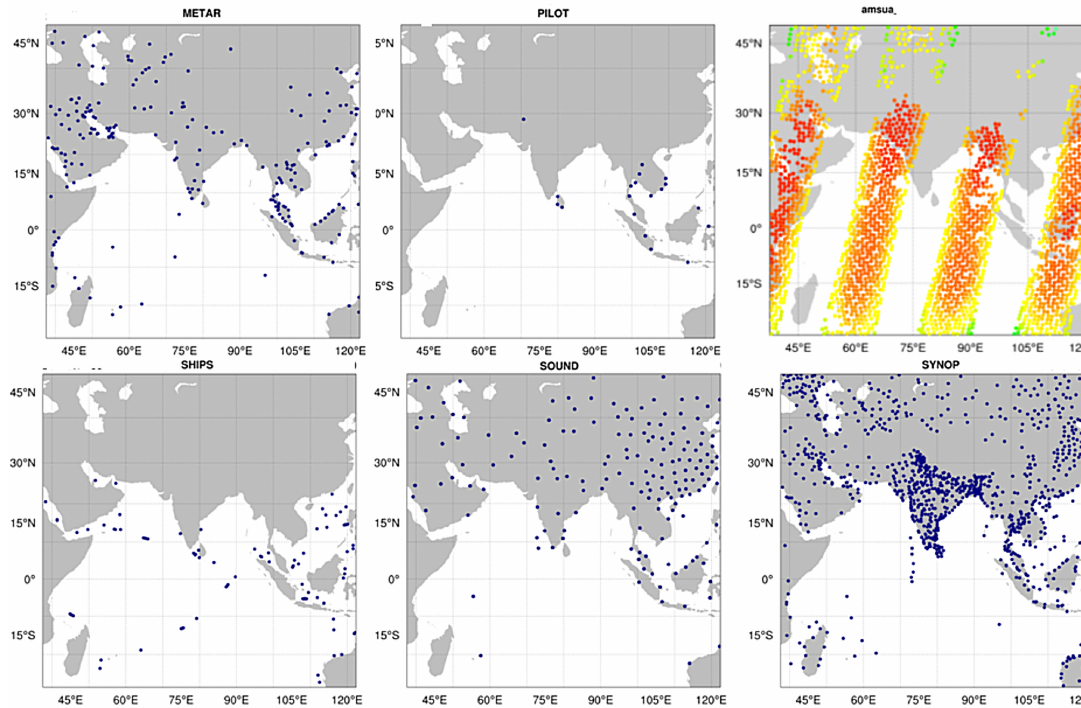
Figure 2. Observations available typically over the domain.